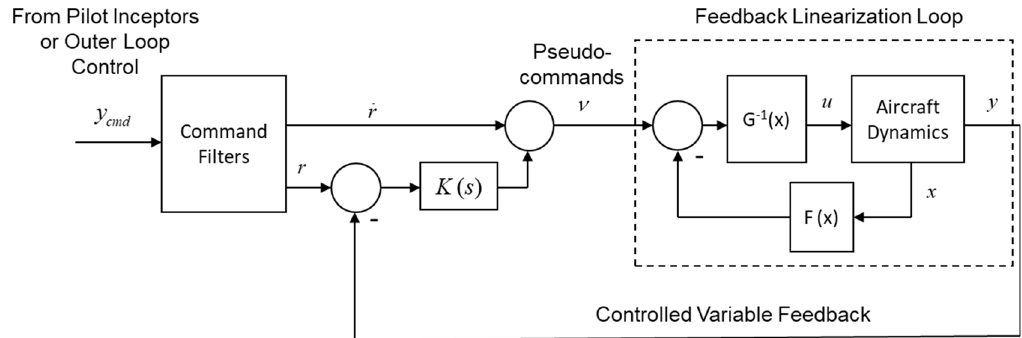
Figure 1. Schematic of dynamic inversion (DI) flight control architecture.